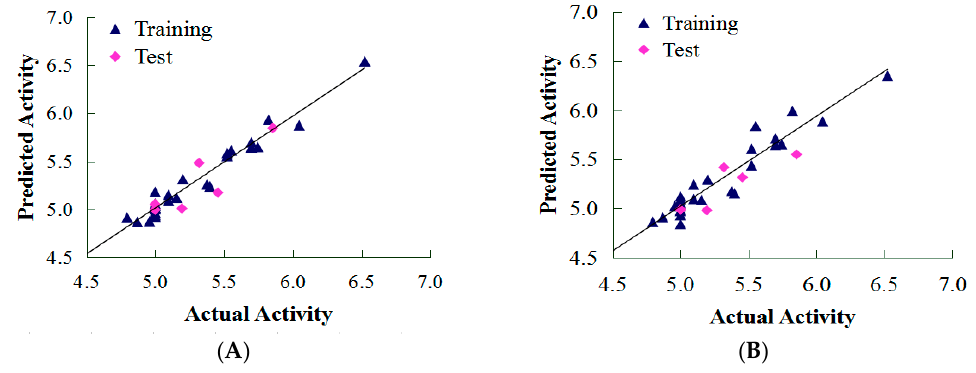
Figure 1. Plots of Actual versus predicted pEC 50 values, for the training set and test set compounds, for CoMFA ( A ) and CoMSIA ( B ) models.